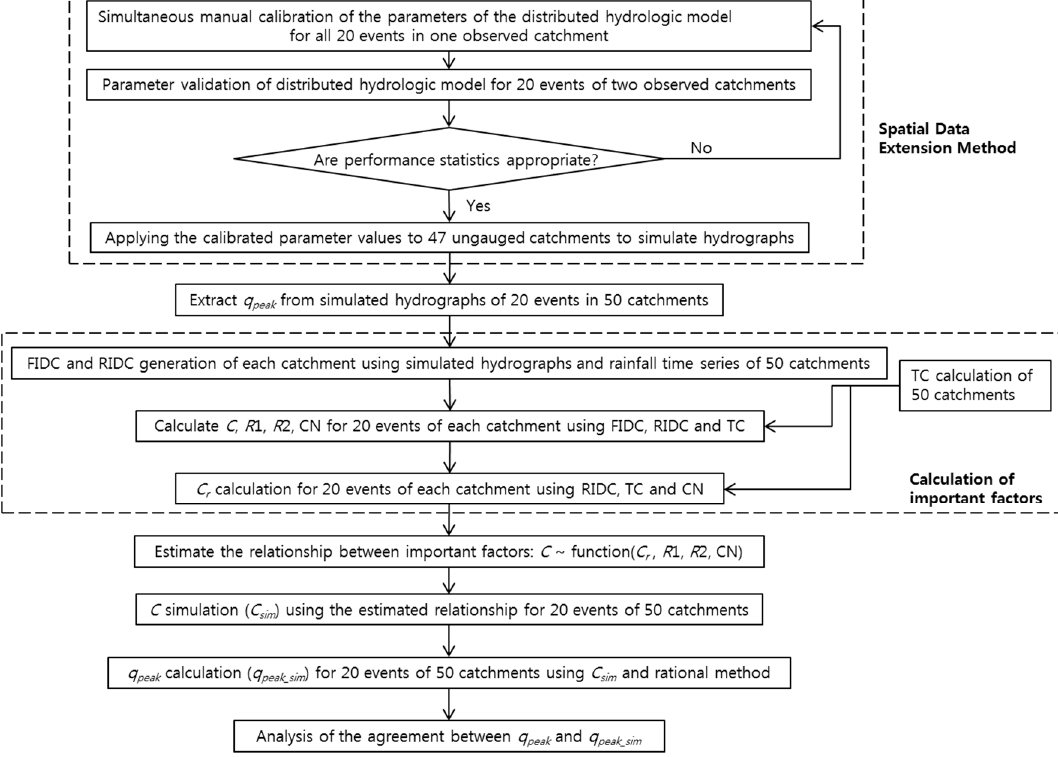
Figure 4. Flow chart for research method.